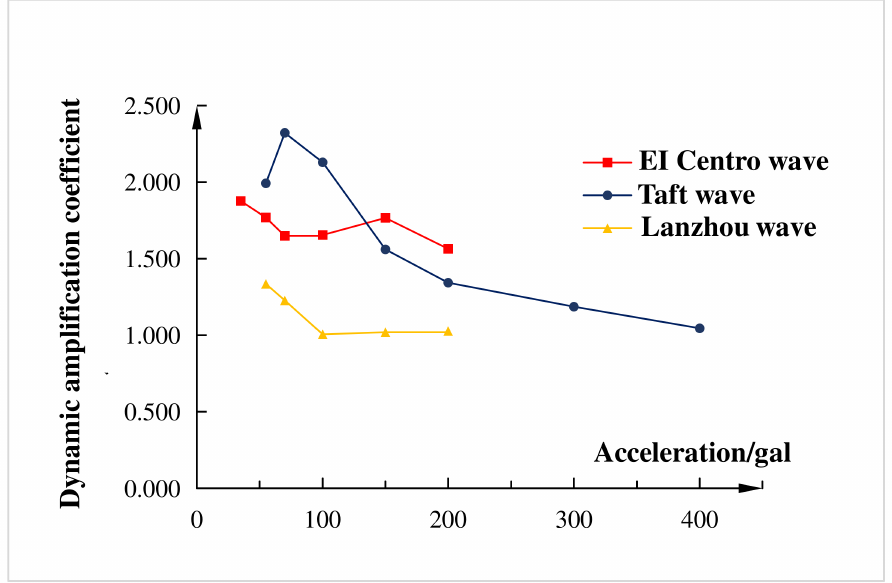
Figure 8. Relationship between dynamic amplification coefficient and input seismic